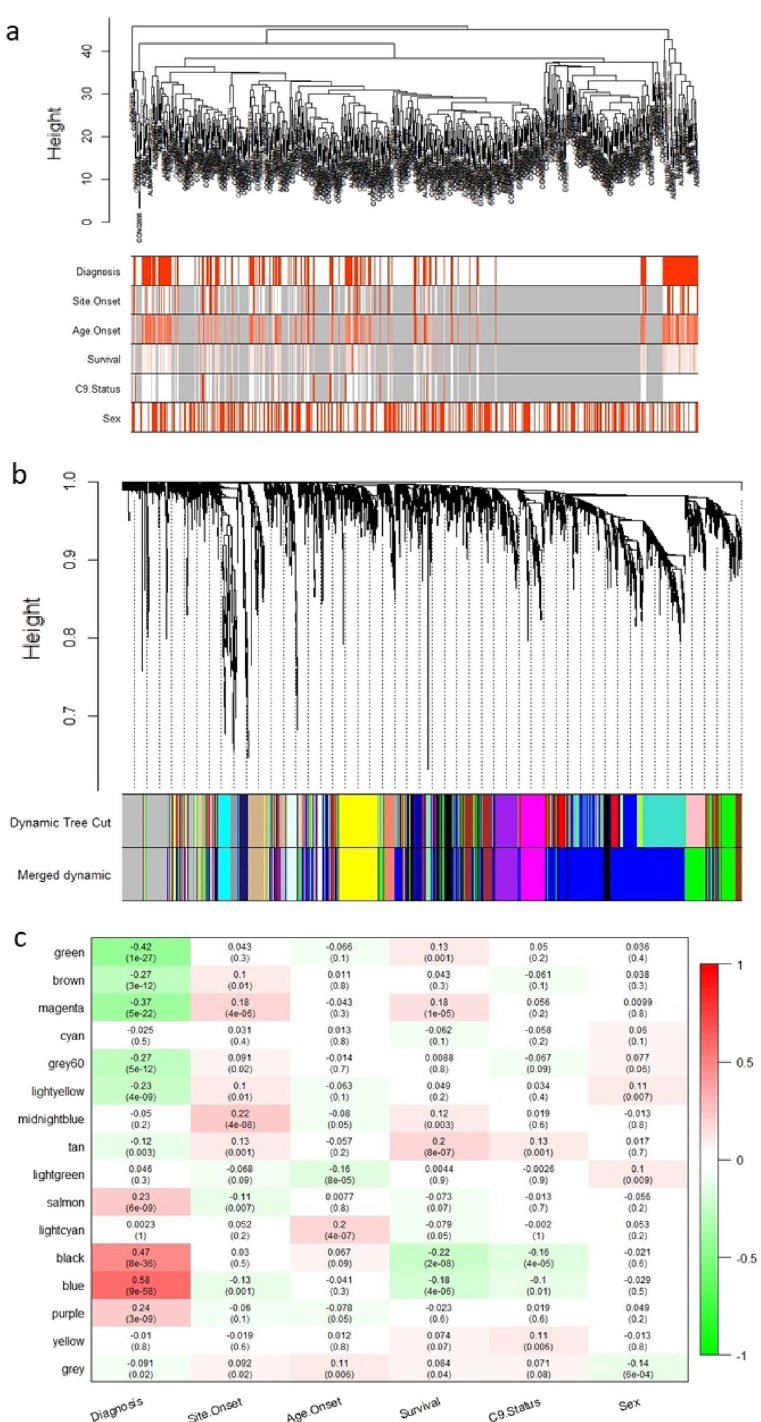
Figure 1. ( a ) Sample dendrogram with traits heatmap. Red is ALS in diagnosis, female in Sex, Spinal in site.onset, Yes in C9 state, the higher value in age.onset and survival. Gray is equal to NA. ( b ) Clustering dendrogram of genes, dissimilarity is based on topological overlap, together with assigned module colors. As a result, 20 co-expression modules were constructed and was shown in different color. Merging the modules with high correlated eigengenes, resulted in 16 modules. The number of genes in each module were listed in Table S2. ( c ) Module-trait associations (ALS vs Control). Each row corresponds to a module eigengene, column to a trait. Each cell contains the corresponding correlation and P-value. The table is color-coded by correlation according to the color